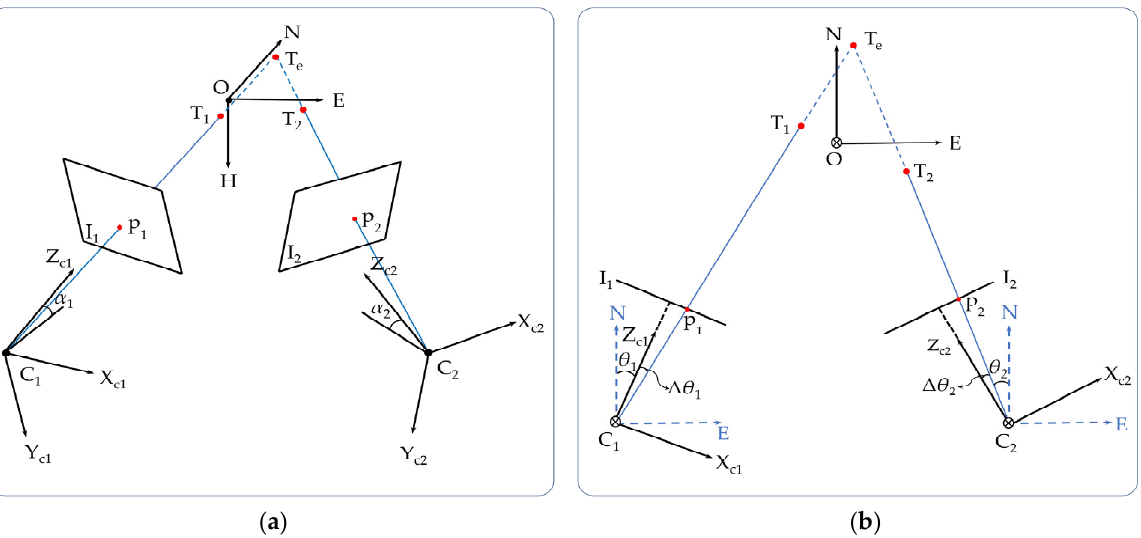
Figure 7. Schematic setup of the cameras and target points in the simulation: ( a ) geometric relations; ( b ) the vertical view. ( b ) the vertical